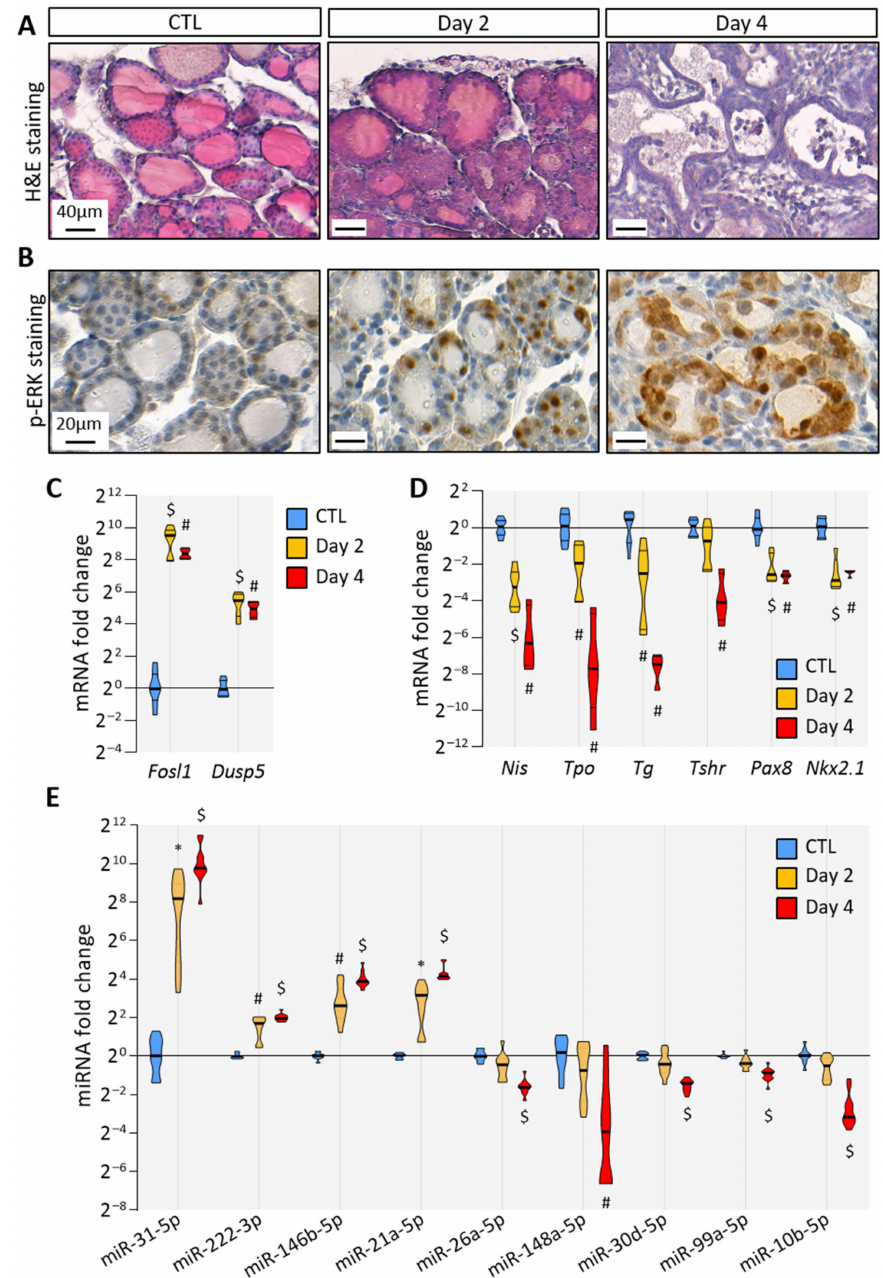
Figure 1. BRAF V600E expression in mouse thyrocytes triggers histological and molecular changes: ( A ) histological staining of thyroid tissues from control and doxycycline-treated mice after 2 and 4 days of intraperitoneal injections; ( B ) immunohistochemistry of phospho-ERK (p-ERK) on thyroid tissues from control and doxycycline-treated mice after 2 and 4 days of injections; ( C , D ) RT-qPCR analyses of ( C ) two MAPK pathway-target genes, and ( D ) thyroid markers in thyroid tissues from control (n = 8) and doxycycline-treated mice after 2 (n = 6) and 4 days (n = 4) of injections. mRNA fold changes are normalized on the geometric mean of Rpl27 and Gapdh expression and compared to the control group; ( E ) miRNA analyses of thyroid tissue from the control (n = 11) and doxycycline-treated mice after 2 (n = 10) and 4 days (n = 11) of injections. MiRNA fold changes are normalized on let-7c-5p and compared to the control group. Data are expressed as the mean ± SD (* p < 0.05; # p < 0.01; $ p <